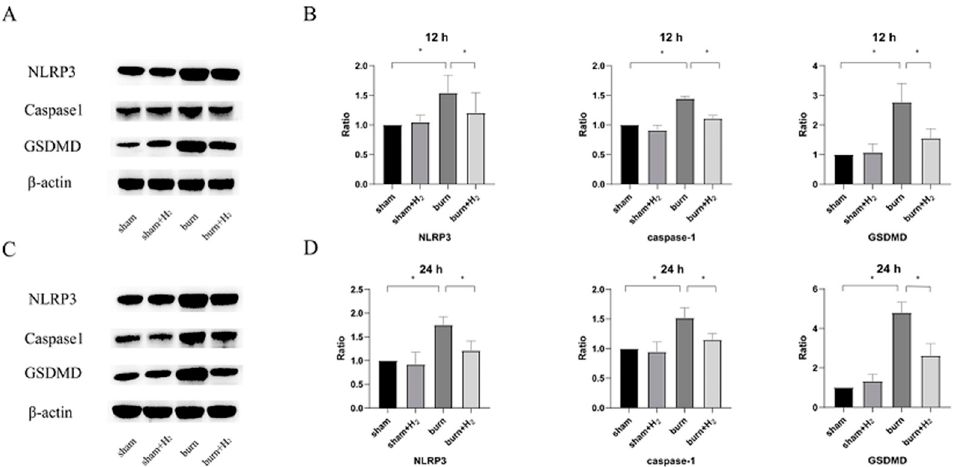
Figure 3. Hydrogen attenuates burn-induced changes in the expression of NLRP3 , caspase-1 and GSDMD at 12 ( A ) and 24 h ( C ) after the burn. The expression levels of NLRP3, caspase-1 and GSDMD were detected by Western blot analysis. Quantitative analysis of NLRP3, caspase-1 and GSDMD ( B , D ) levels, shown as the ratio of each protein band density to that of β -actin ( n = 6 rats per group). * p < 0.05. * p < 0.05.